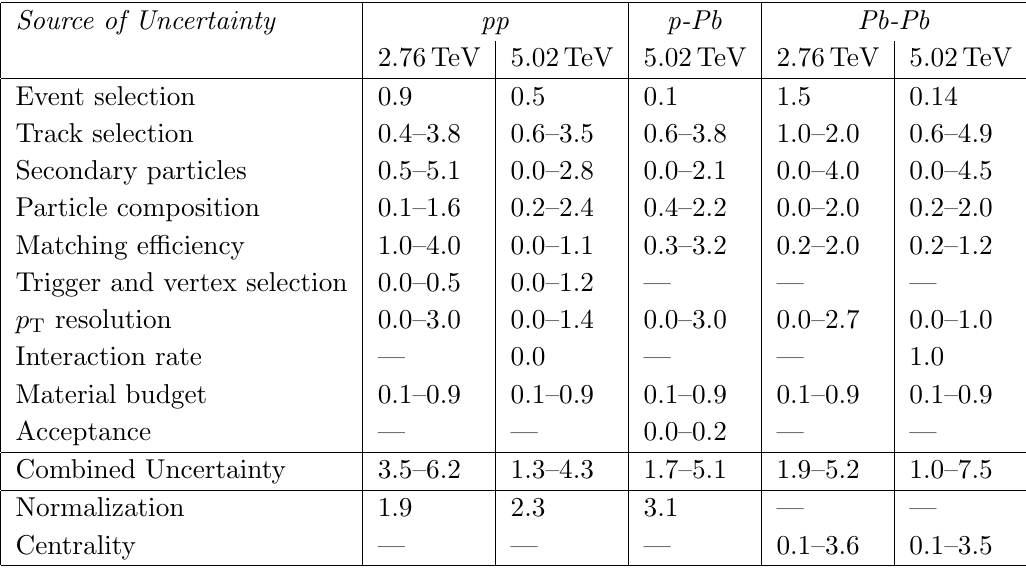
Table 2 . Contributions to the relative systematic uncertainty for p T spectra in pp, p-Pb, and Pb- Pb collisions. The ranges correspond to the maximal variation within the considered p T range of 0.15{50 GeV/ c , as well as Pb-Pb centrality intervals. The p T -dependent contributions are assumed to be independent and are summed in quadrature, resulting in the combined uncertainty. All values are in